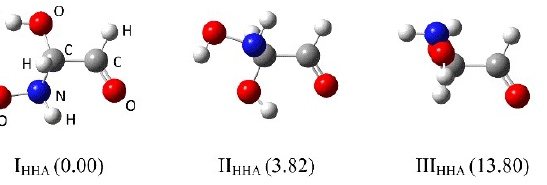
Figure 6. The optimized structures of the three most stable forms of hydroxy(hydroxyamino)acetaldehyde, HHA . The computed ∆E (ZPE) energies of HHA conformers with respect to the energy of the most stable conformer, I HHA , in kJ mol −1 are given in parentheses.